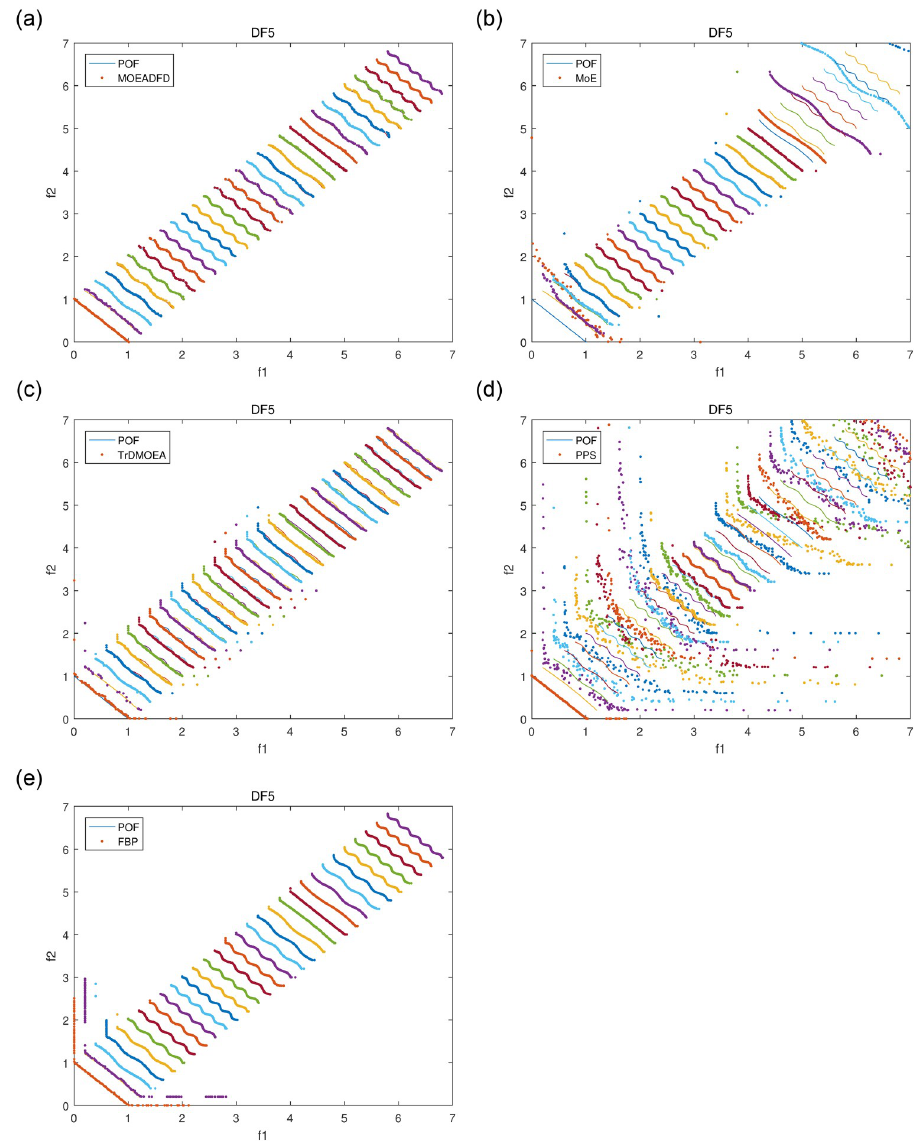
Fig 5. POF approximations of five algorithms for DF5 with n